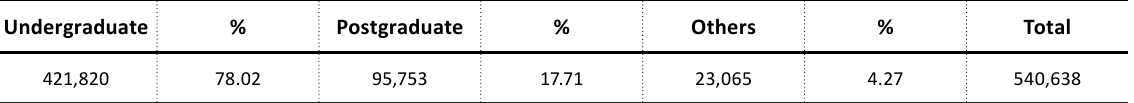
Table 9. Enrolment and percentage of graduates at public higher education institutes Source: Planning, Research and Policy Coordination Division, MOE